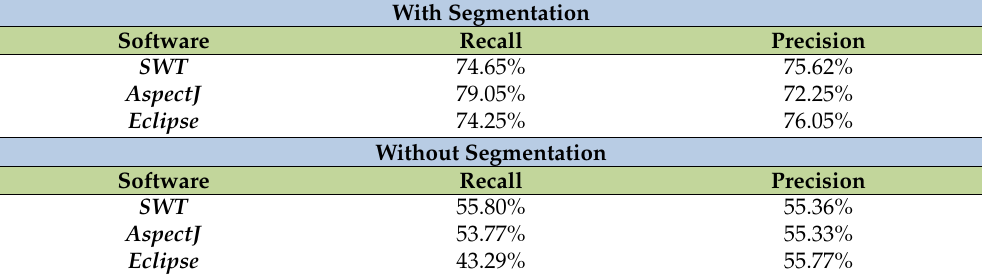
Table 2. Recall and precision for